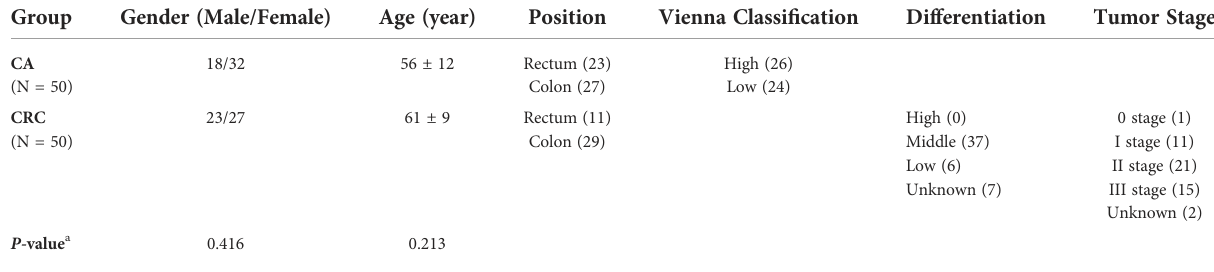
TABLE 1 Basic clinical information of study